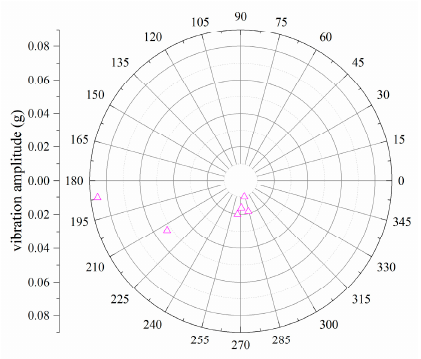
Figure 28. Vertical polar diagram of trailing-edge flap.